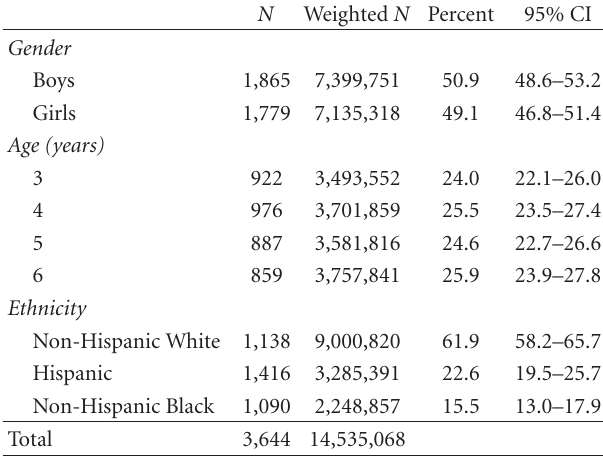
Table 2: Demographic characteristics of 3,644 3-to-6-year-olds in the National Health and Nutrition Examination Survey,